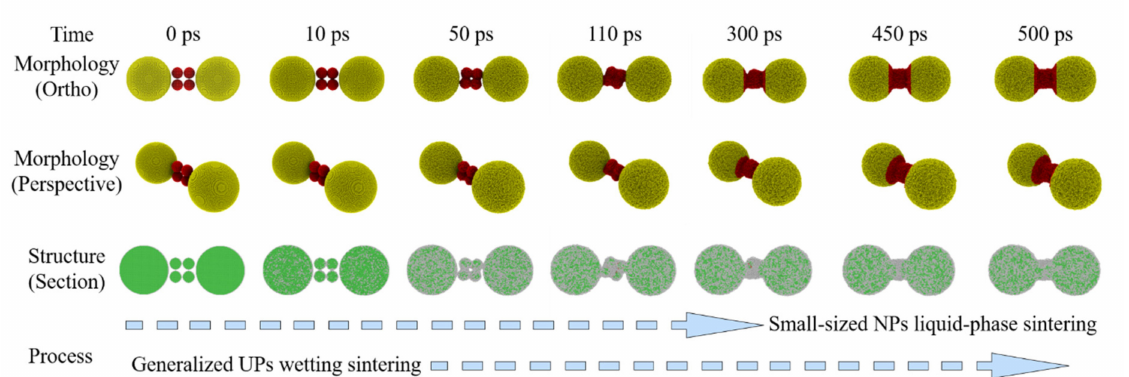
Figure 17. UPs-like local structures in MPs, in which large amounts of small EPs dope among large EPs.